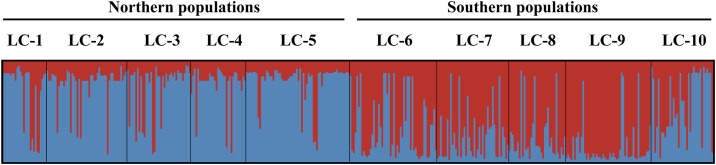
Results of STRUCTURE for all Lilium cernuum studied individuals.Assignation of individuals to genetic clusters is at K = 2.